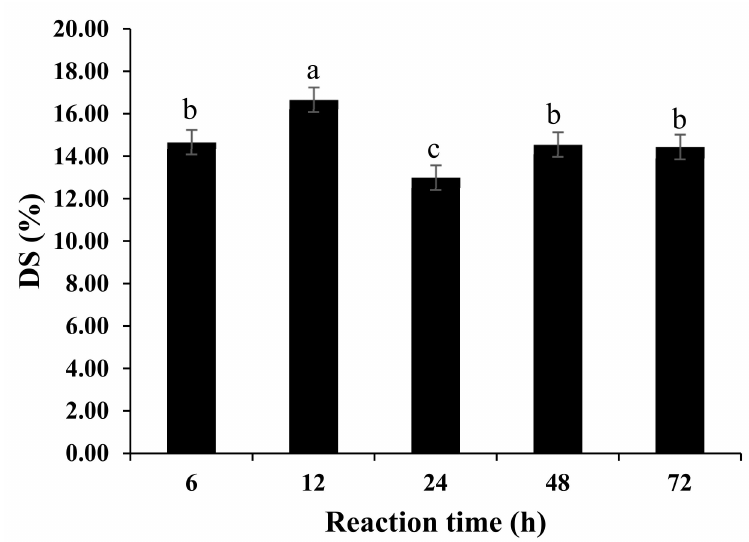
Figure 1. E ff ect of Maillard reaction time on the degree of substitution in ODF-SPI conjugates. Di ff erent letters indicate significant di ff erence. Table 1. E ff ects of micronization and Maillard reaction on the amino acid profiles of ODF-SPI conjugates. Amino Acid (%, Dry Weight